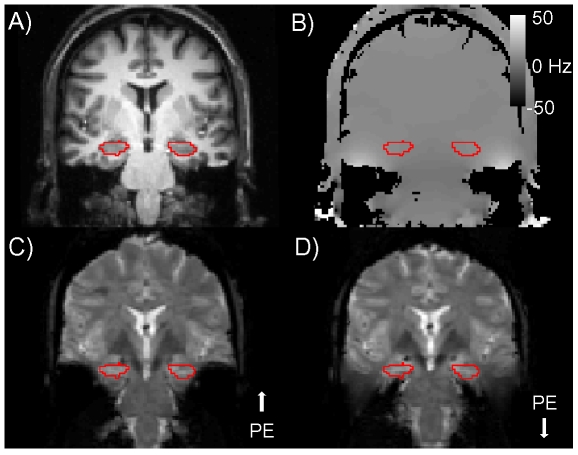
Reversing the direction of the phase-encode gradients reverses the direction of distortion.(A) Reference anatomical image for an oblique coronal slice (perpendicular to hippocampal axis) through anterior hippocampus (red boundary). (B) Field map (colorbar indicating frequency offsets in Hz) for same the slice; ROI boundary is the same as in (A). (C) High resolution, full field of view EPI image with phase-encode (PE) in the Foot-Head direction. Susceptibility artifacts decrease the static magnetic field in medial temporal lobe and shift signal from PHG toward the feet (notably, hippocampus is not affected). Increased B0 (static magnetic field strength) in lateral temporal lobe shifts signal toward the top of the head. (D) Reversing the phase-encode direction reverses the direction of distortion, pushing PHG signal up into hippocampus. The choice of phase encode direction can affect localization accuracy when fieldmap-based distortion compensation techniques are used during data analysis.